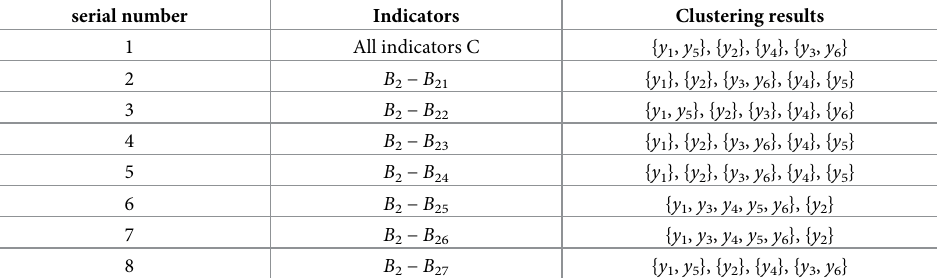
Table 7. Clustering